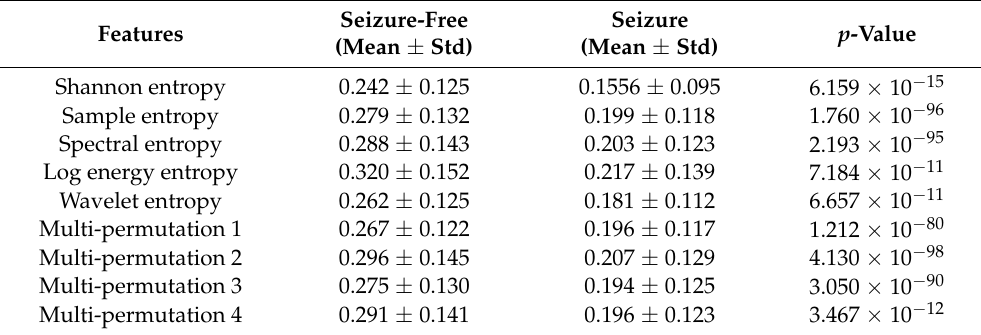
Table 3. Range of values of the complexity measures for the two classes of seizure and seizure-free. The lowest p -value of 4.130 × 10 − 98 for multi-permutation entropy at level 2 indicates the great discrimination capability of this feature in characterizing seizure